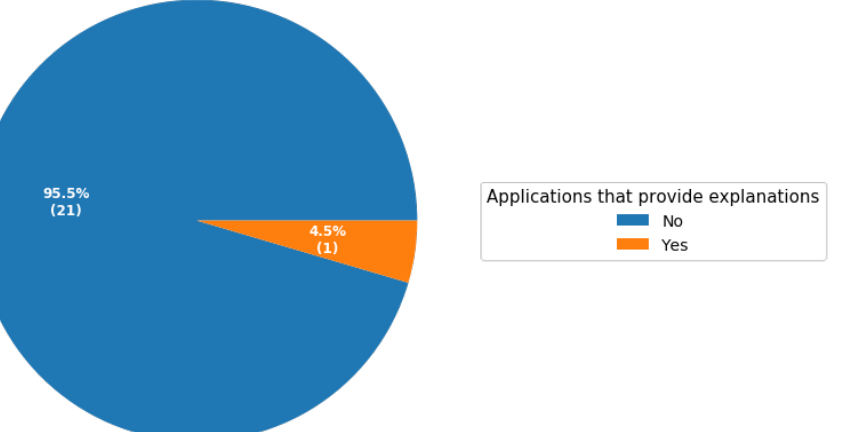
Figure 6. Percentage of mobile computer vision-based applications explain to users how the model makes predictions. The number in brackets indicates implemented computer vision-based applica- tions that explain to users how the factors influence model prediction from the surveyed studies.